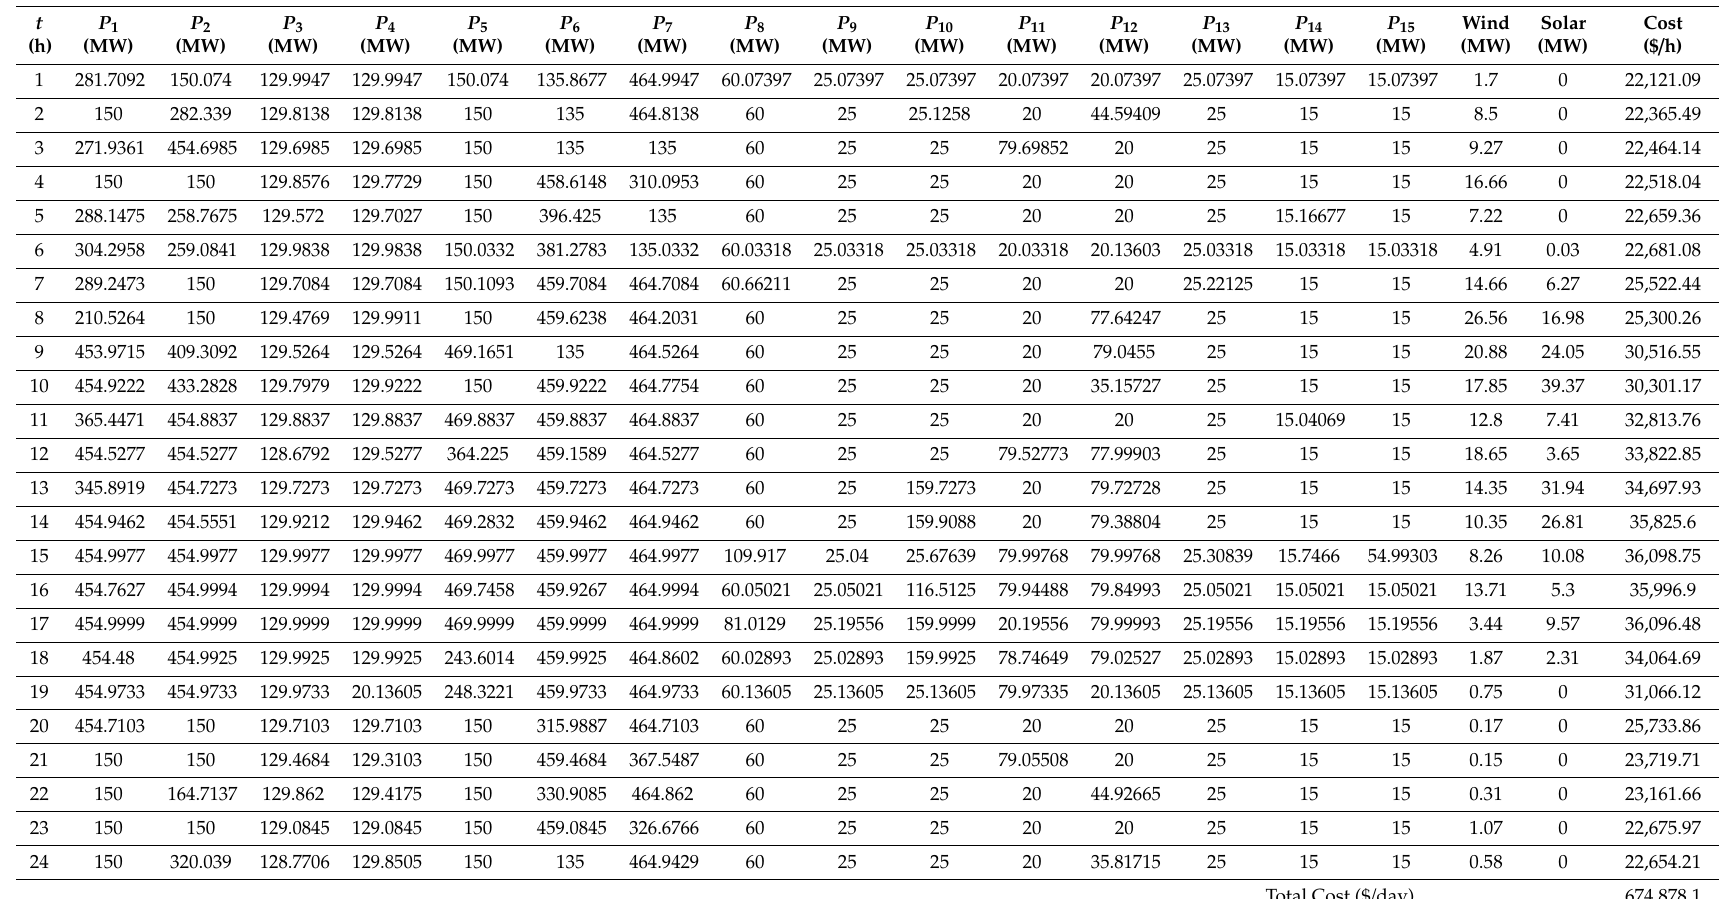
Table 11. The BA on a 15-unit system with